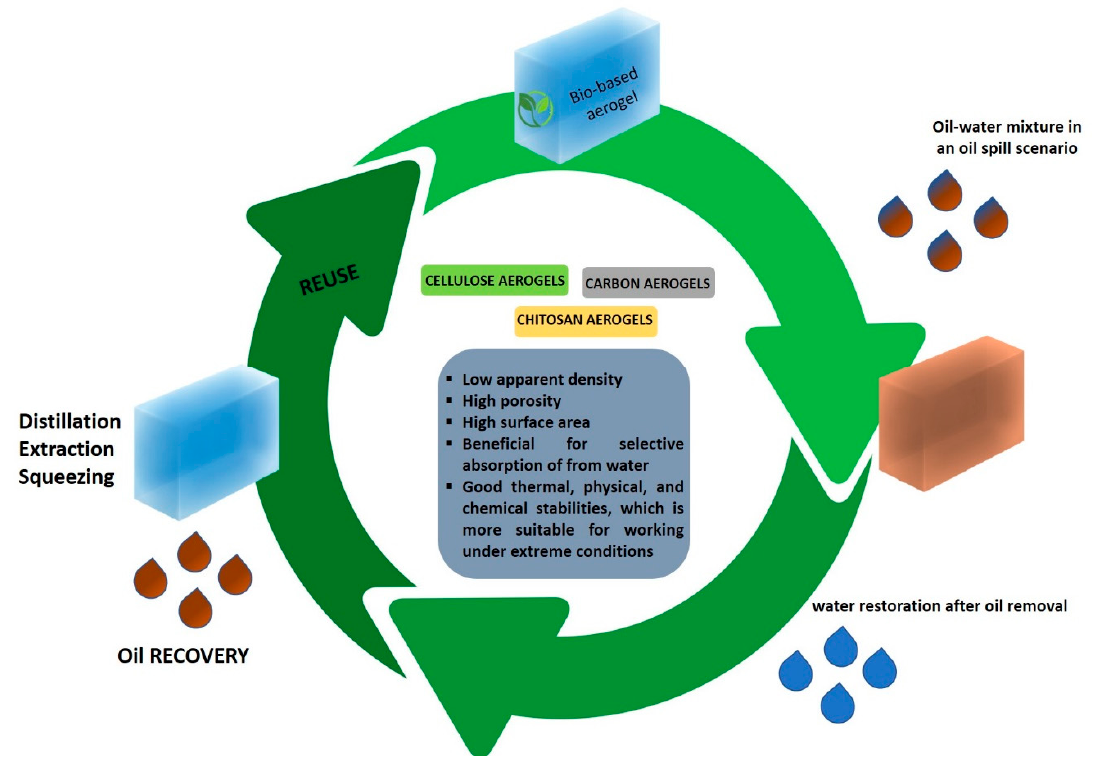
Figure 6. Natural ‐ based aerogels for removing oil emulsified from water. Figure 6. Natural-based aerogels for removing oil emulsified from water.